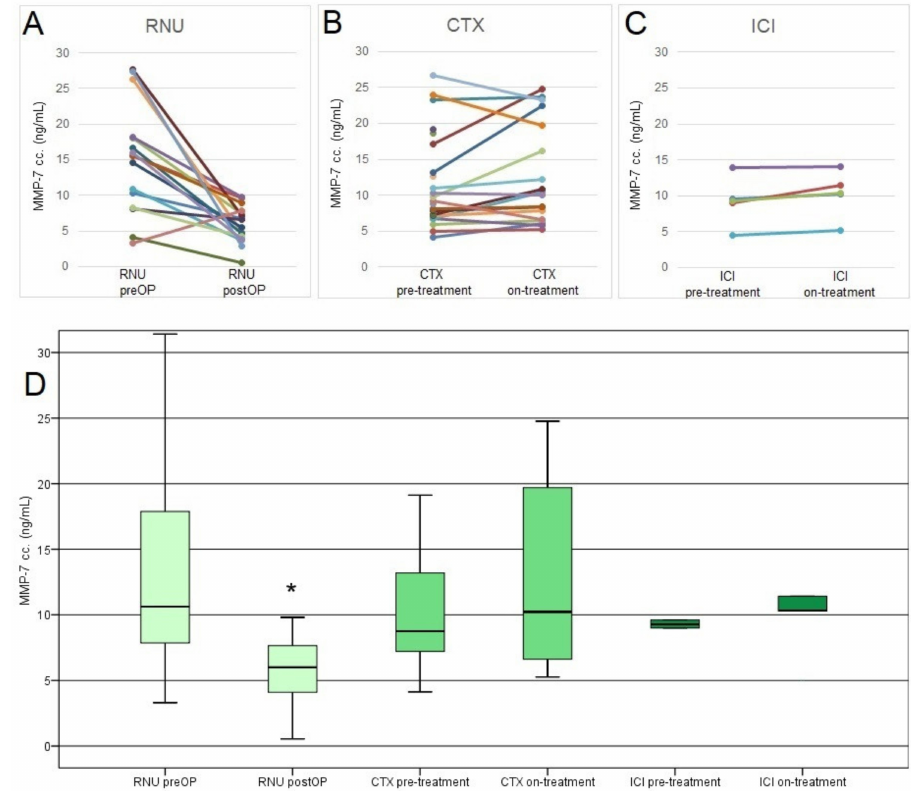
Figure 3. ( A ) Changes of MMP-7 concentrations in the RNU cohort (preop. and postop. values). ( B ) Changes of MMP-7 concentrations in the CTX cohort (at chemotherapy baseline and on the first day of cycle 2). ( C ) Changes of MMP-7 concentrations in the ICI cohort (pre-treatment and on-treatment values). ( D ) Changes of MMP-7 concentrations in the RNU, CTX, and ICI cohorts (* significant difference); RNU—radical nephroureterectomy; CTX—chemotherapy; ICI—immune checkpoint inhibitor